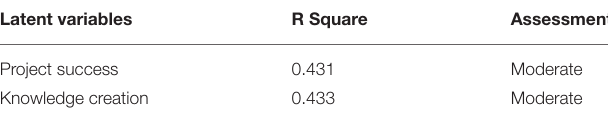
TABLE 10 | Coefficient of